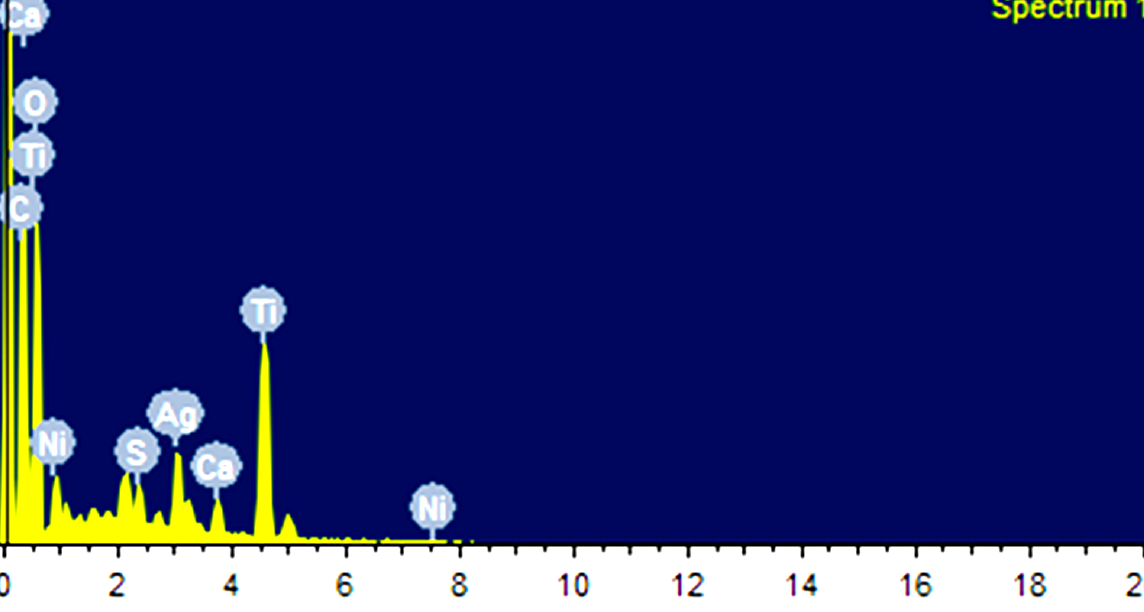
Figure 2. SEM images of CA ( a – c ), Ni 3 S 4 /CA ( d – f ), Ag 2 S/CA ( g – i ) and Ni 3 S 4 /Ag 2 S/TiO 2 /CA ( j – l ) at different magnifications.